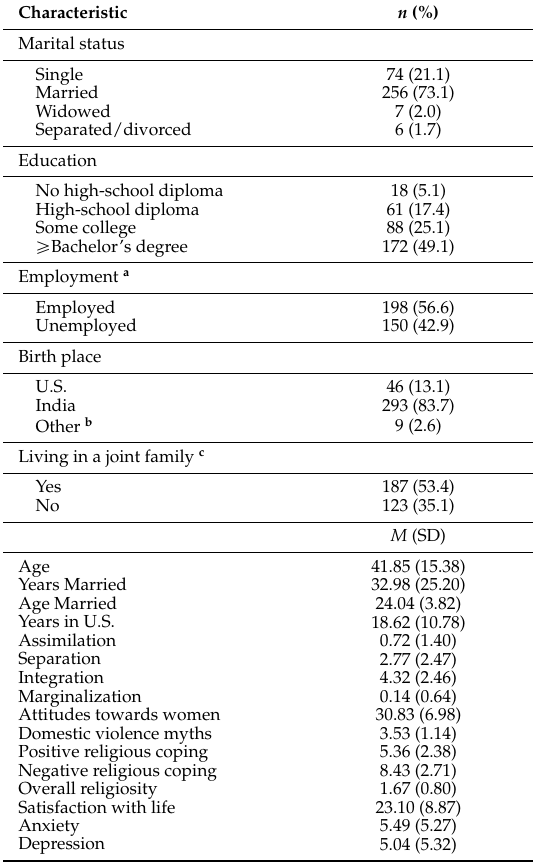
Table 1. All survey participants ( N =